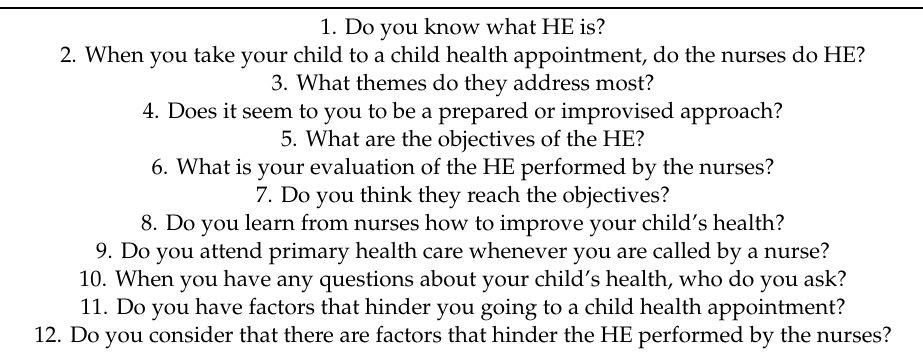
Table 1. Semi-structured guide used with the